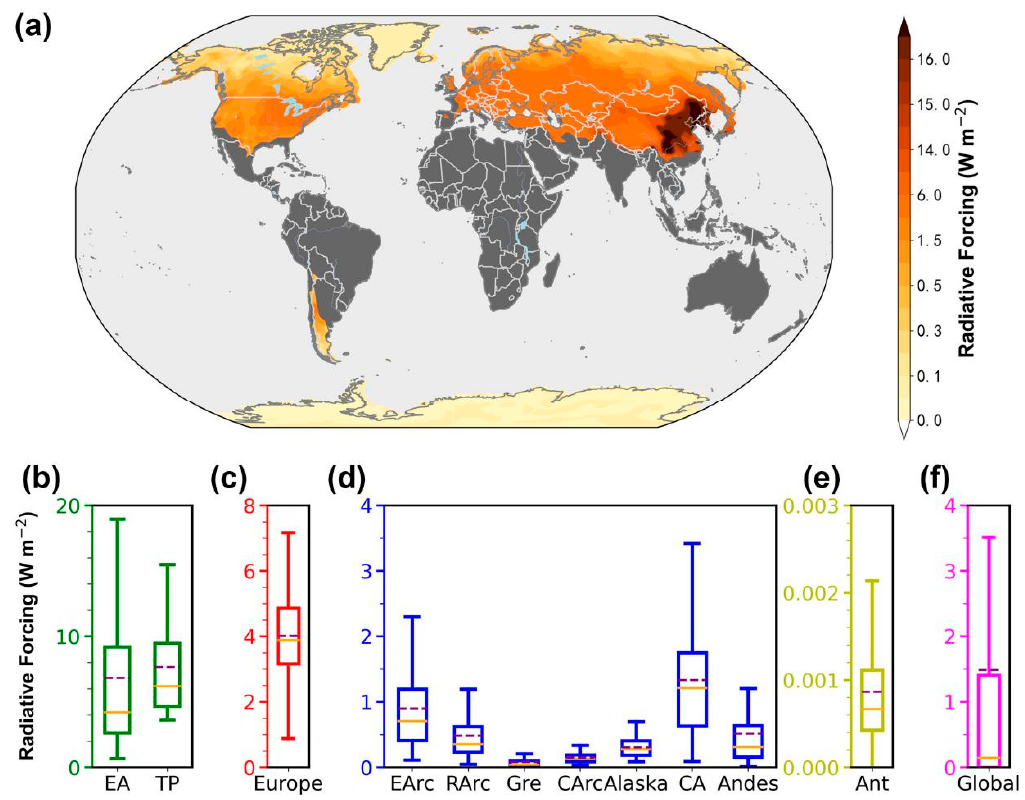
Figure 6. Global distribution of radiative forcing associated with CMIP6 multi-model mean BC con- centrations in snow ( a ) and statistical results ( b – f ), averaged globally and regionally over 1980–2014.